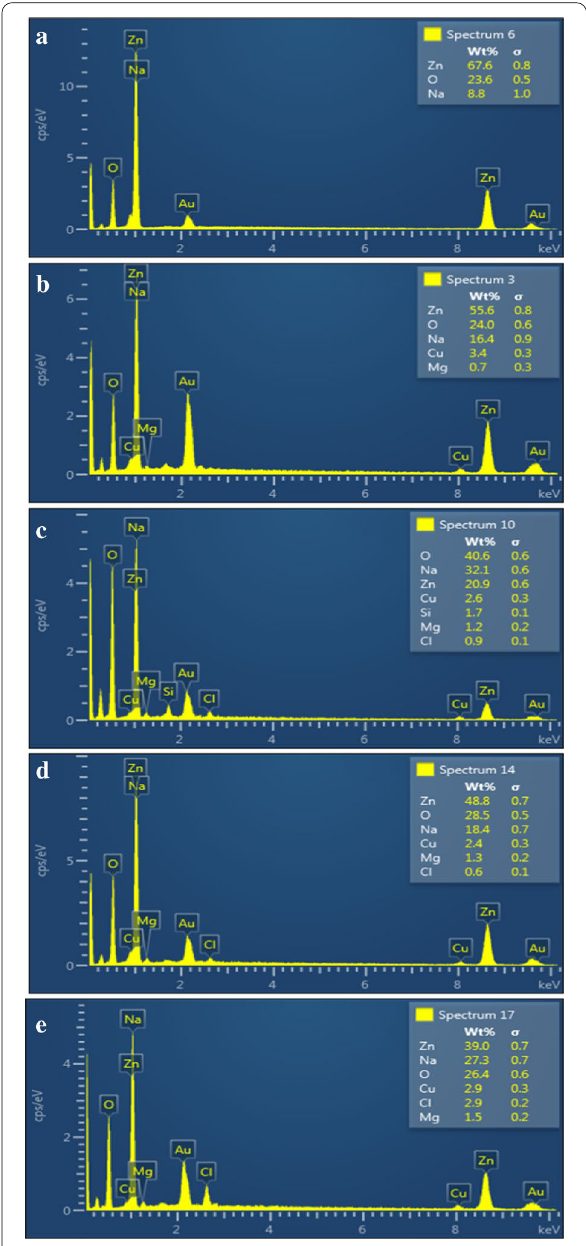
Fig. 5 a EDS analysis of ZnO and various concentrations (2, 4, 6 and 8 wt%) of Mg‑doped ZnO ( b–e ),